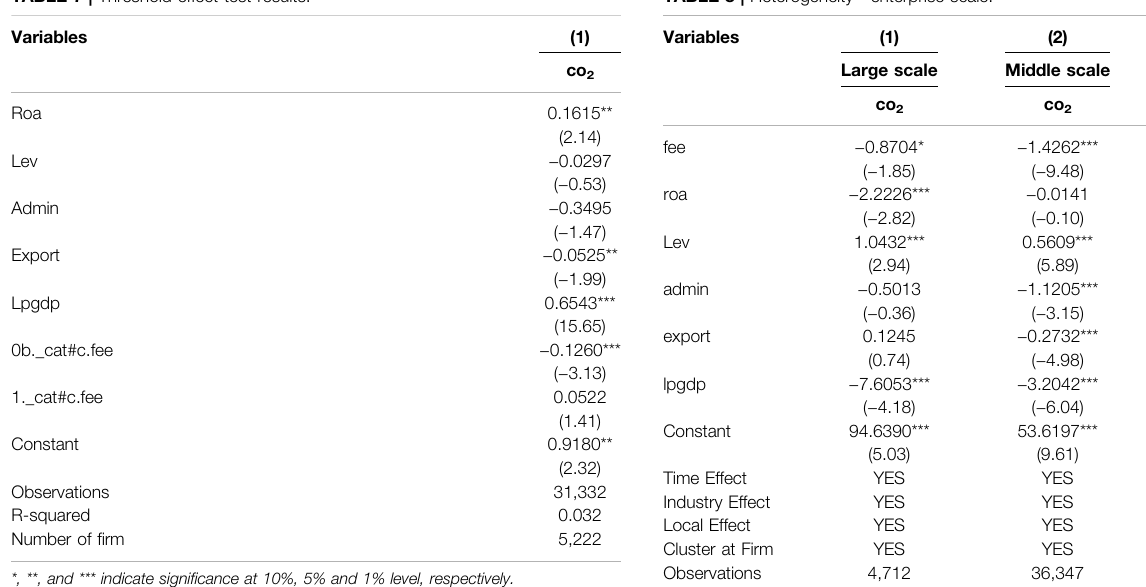
TABLE 7 | Threshold effect test results. TABLE 8 | Heterogeneity — enterprise scale.